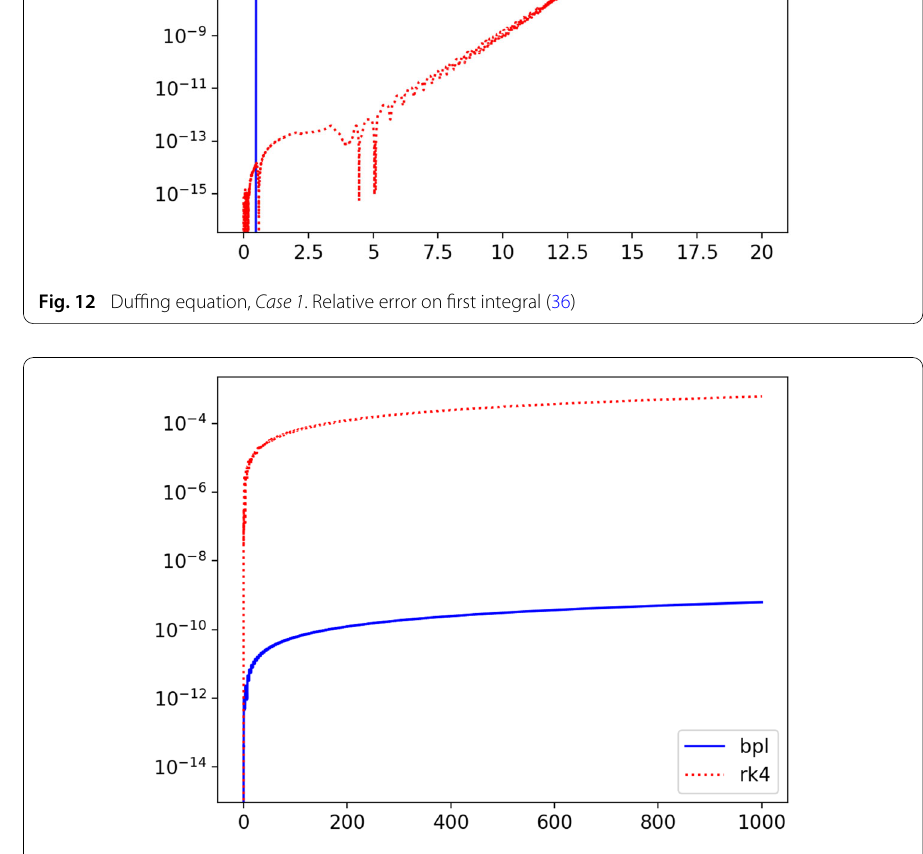
Fig. 13 Duffing equation, Case2 . Relative error on first integral